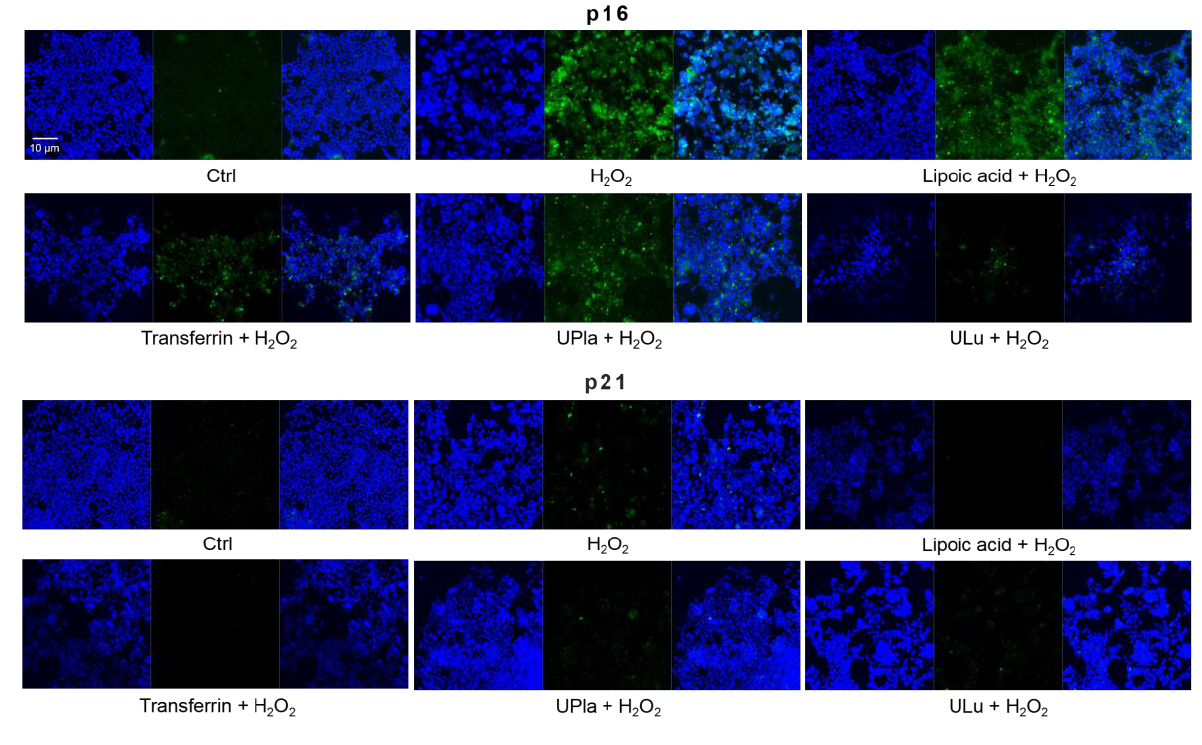
Figure 7. Mitochondrial ROS assessment with mitochondrial dye MitoTracker Green and mitochon- drial ROS indicator MitoSox Red, with visualization by confocal microscopy. The results represent similar results of three independent experiments. Mito ROS: mitochondrial